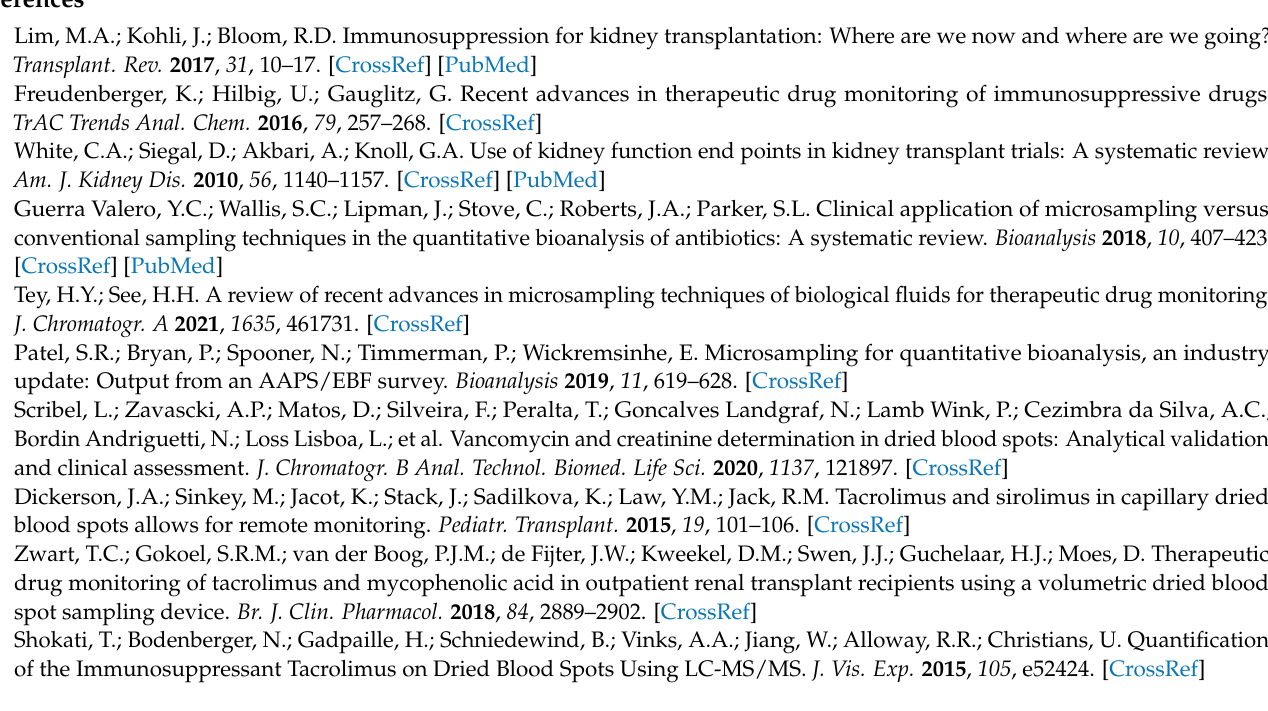
Figure S1: The working diagram of volumetric absorptive microsampling; Figure S2: representative ion chromatogram peaks; Figure S3: mean deviation and CV values were obtained from three analytes in different HCT values; Figure S4: Validation of short- and long-term stability in VAMS